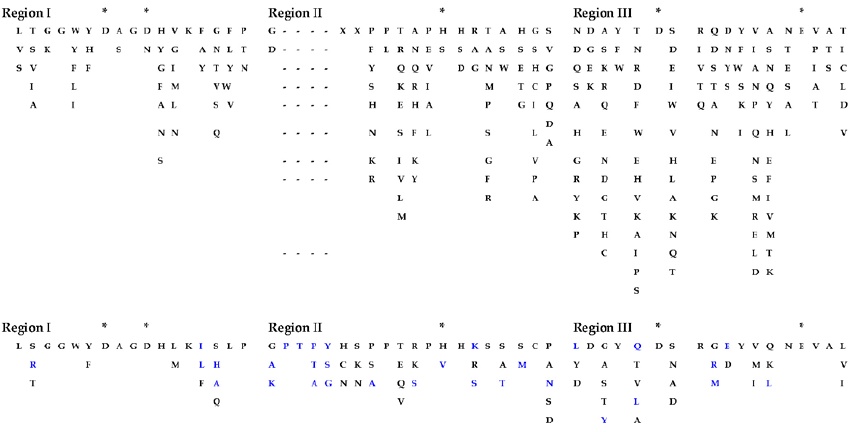
Figure 1. Variation in amino acids at each position within three conserved motifs of microalgal cellulases compared to other consensus sequences of GH9 cellulases from across the taxonomic groups. The sequences from different taxonomic groups were chosen, as mentioned in Figure 2.